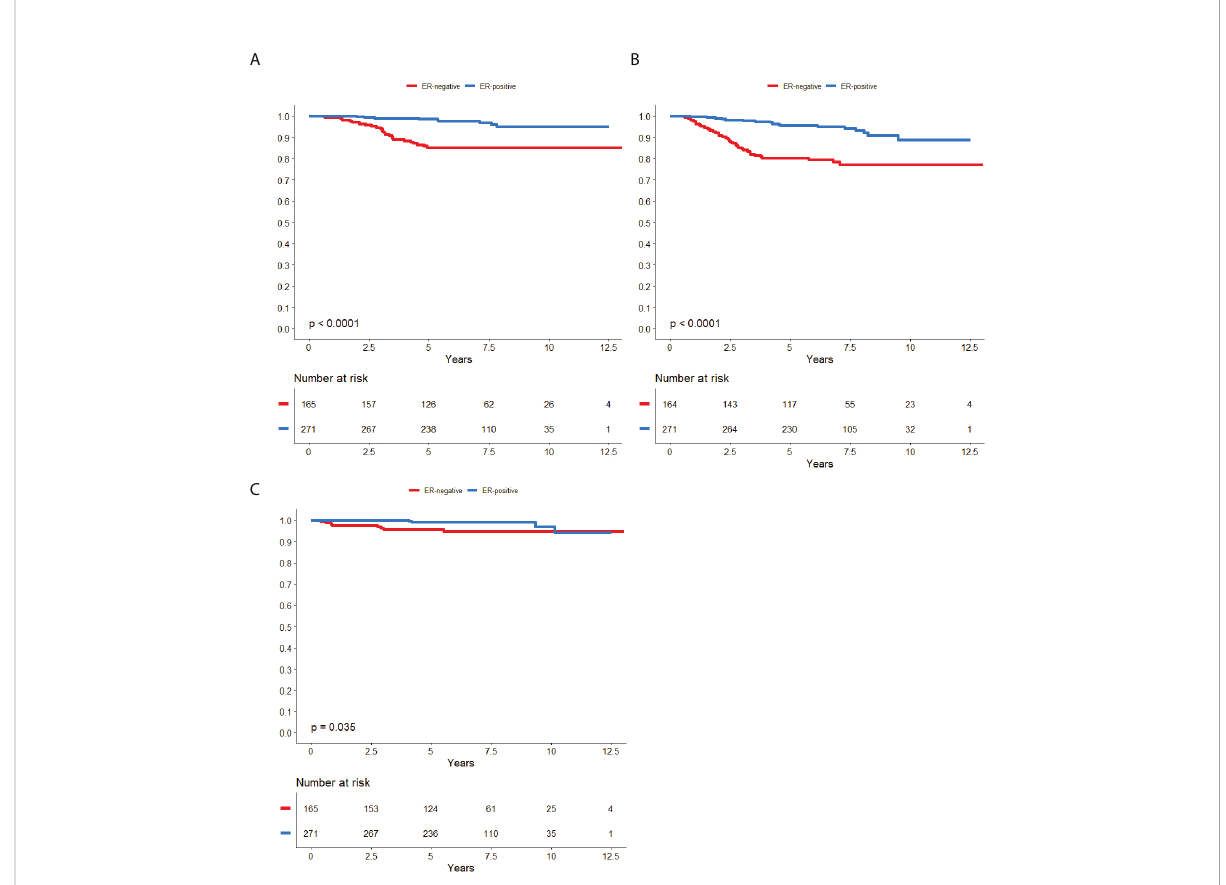
FIGURE 4 ER-status in relation to BCSS (A) , DRFS (B) and LRFS (C) respectively in patients that was treated with